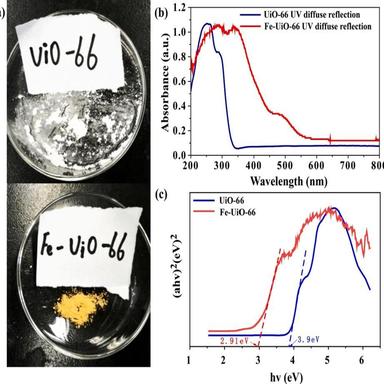
(a) Photographs of Fe-UiO-66 and UiO-66; (b) UV–vis DRS full scan (c) Tauc's plots (αhν) 2 vs. photon energy (hν) to obtain the band gaps of Fe-UiO-66 and UiO-66 composites.